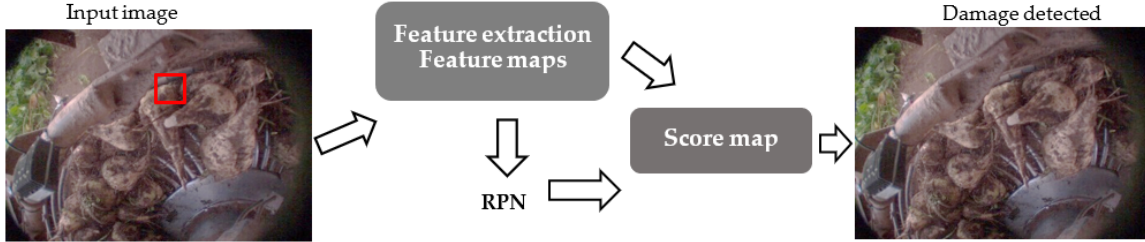
Figure 6. Schematic representation of R-FCN for sugar beet damage detection.